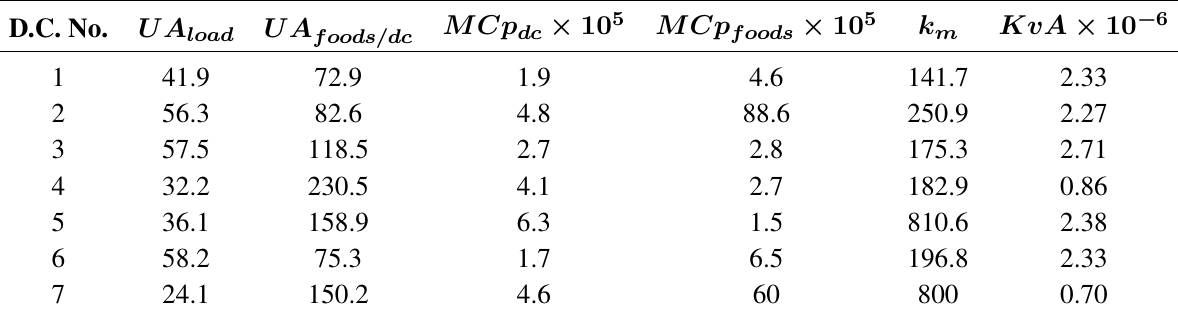
Table 1. Estimated parameters of the display cases.